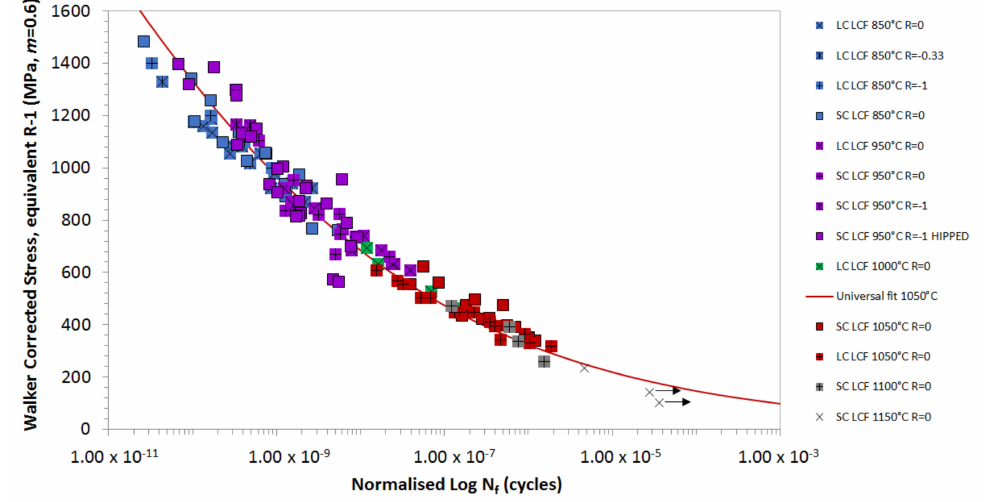
Figure 3. Isothermal fatigue data normalised to 1050 ◦ C to account for relative oxidation performance, and used to produce a universal LCF